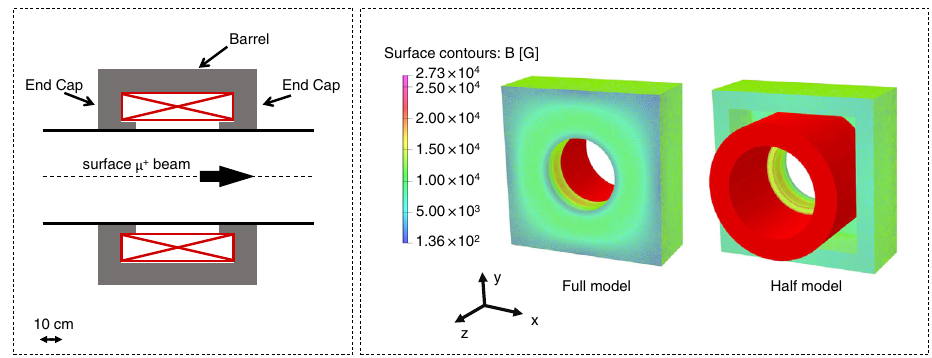
FIG. 12. Model 1: the typical iron housing solenoid in OPERA .